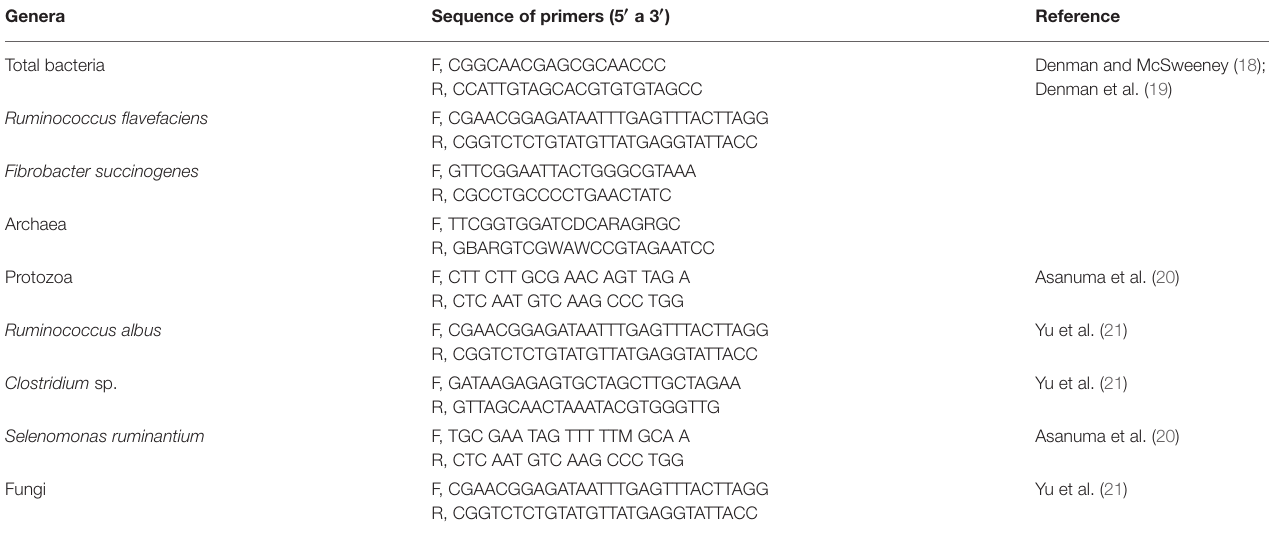
TABLE 3 | Primers used for the quantitative analysis of ruminal microbial populations.